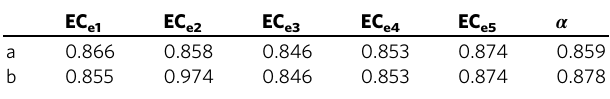
Table 6 Krippendorff ’ s alpha-reliability